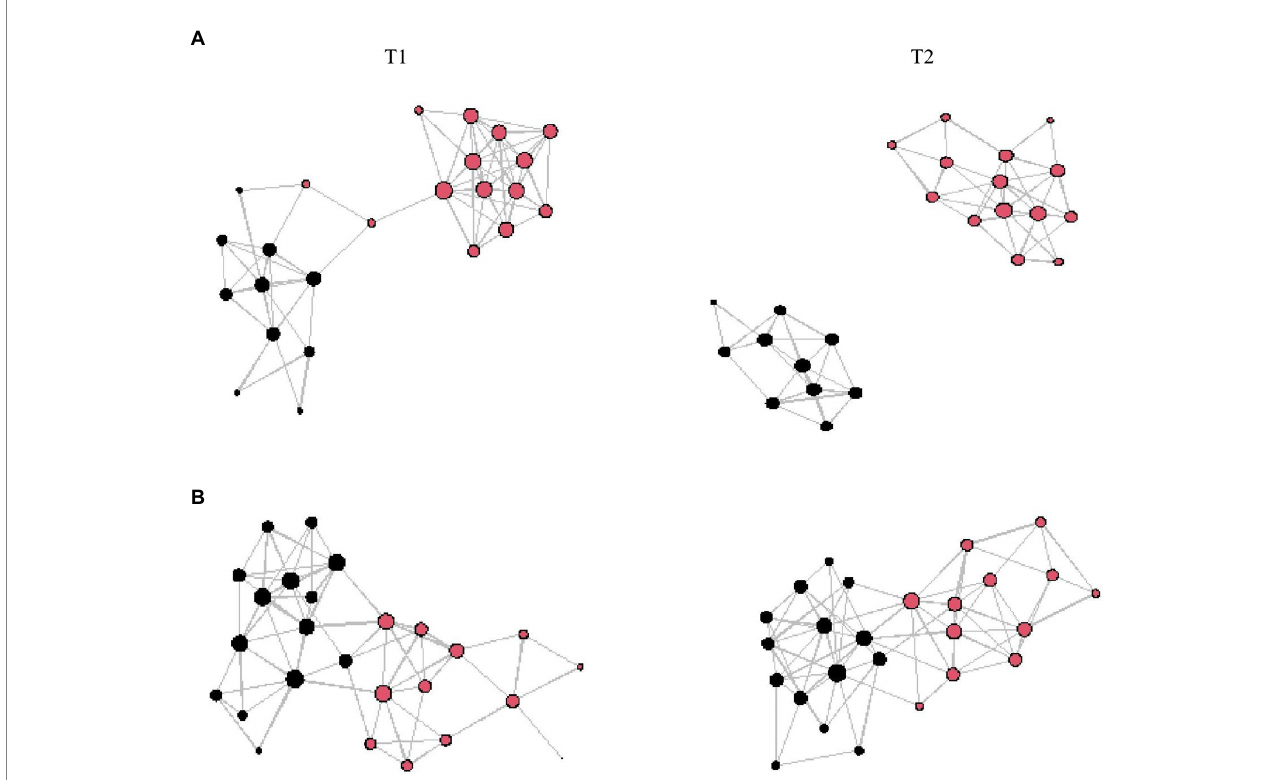
FIGURE 1 Visualized networks taking gender into account (red represents female students, black represents male students); the size of the dots reflects the degree of connections; the length of the lines does not communicative substantive information; (A) Interaction during lessons in EOtC class, (B) Interaction during lessons in comparison class; T1 = first time point; T2 = second time point.